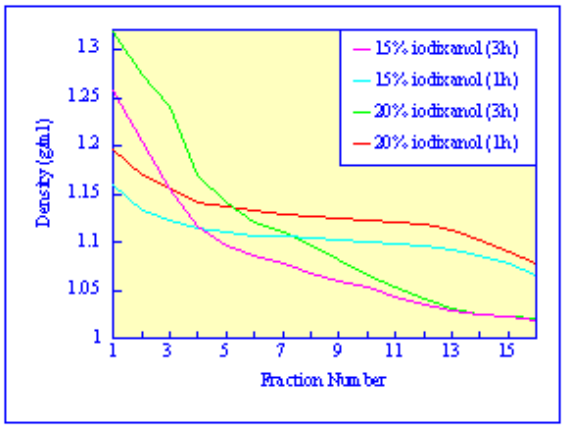
FIGURE 3 . Density profiles: 350,000 g at 15 o C in TLN 100.